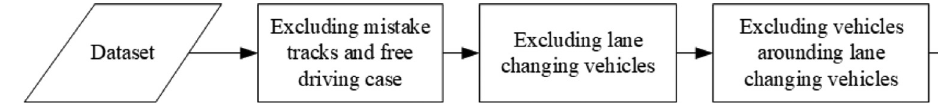
Figure 4 Data fi ltering